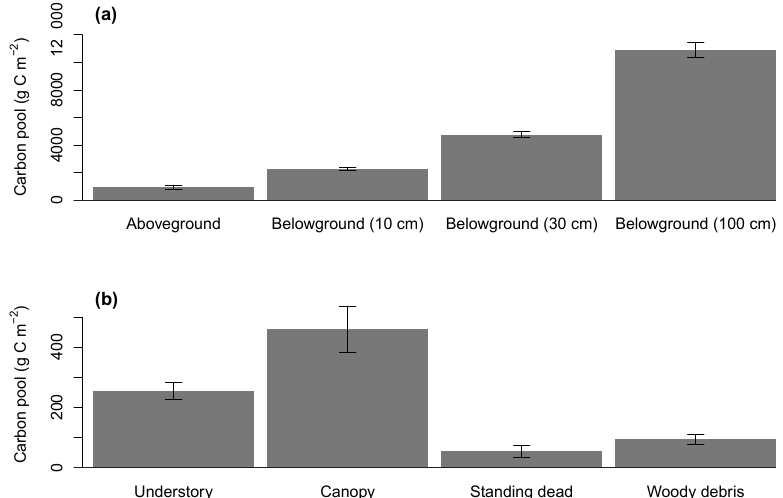
Figure 2. Average carbon density of all sites in the Y4 watershed ( a : above- and belowground to 1m; b : aboveground only). Bars indicate standard